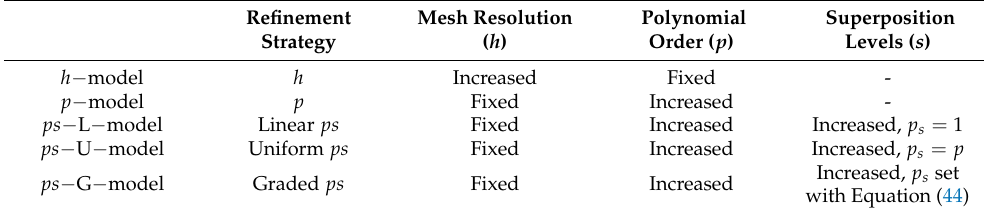
Table 5. Nomenclature for finite element models.